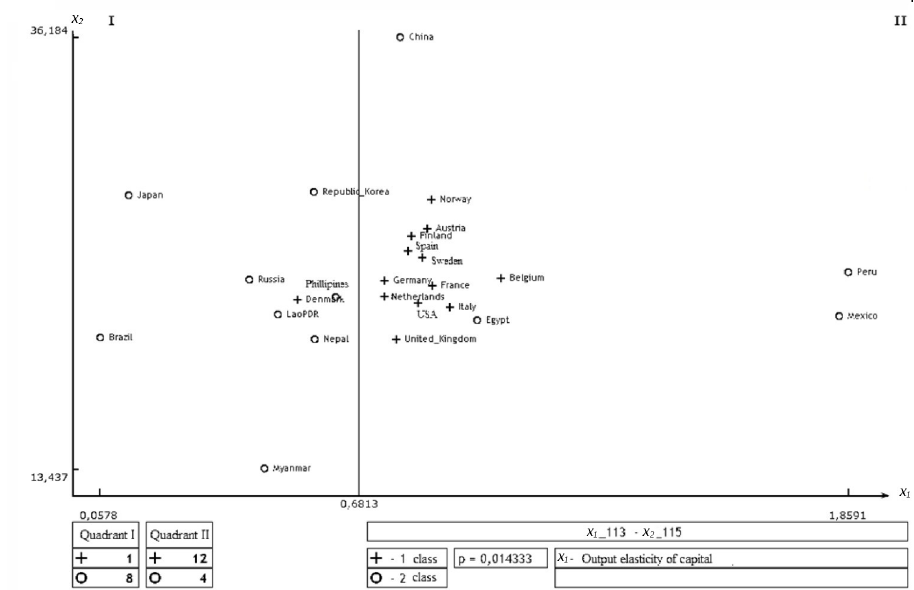
Figure 1. One-dimensional regularity describing the dependence of the institutional type on the output elasticity of the